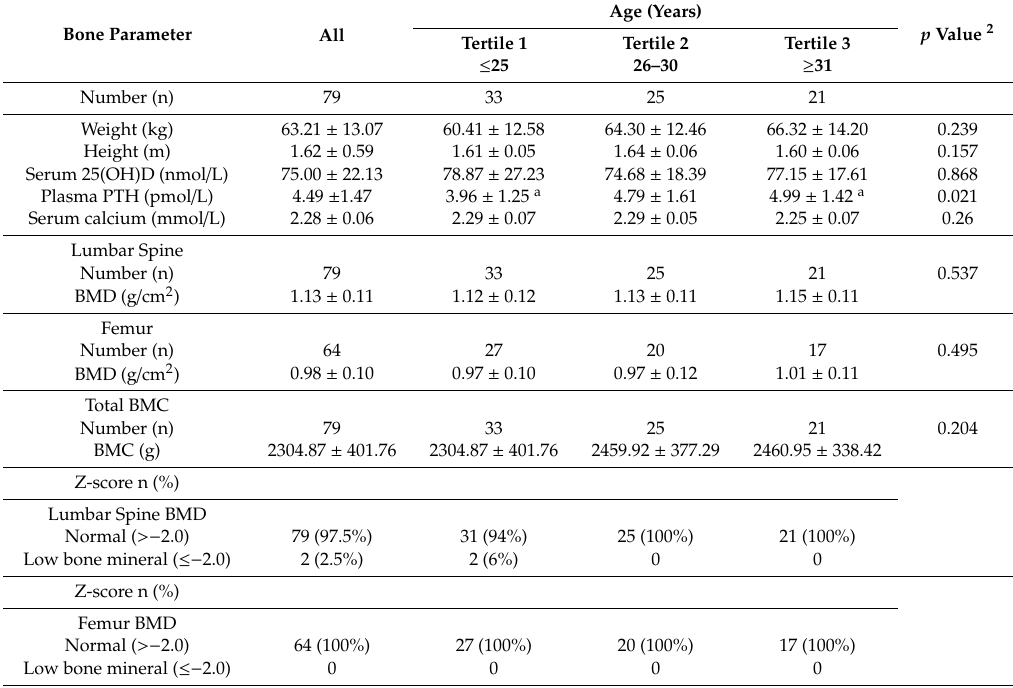
Table 3. Lumbar spine and femur bone densitometry assessed by Dual-energy X-ray absorptiometry (DXA) of Brazilian women living in Brazil by age tertiles ( n = 79) 1